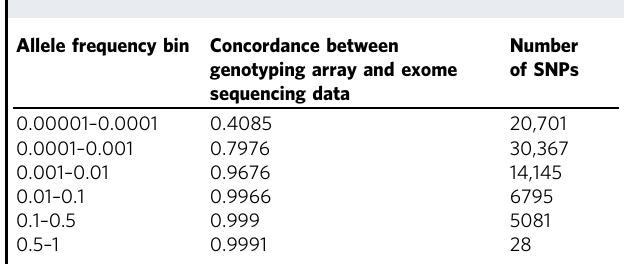
Table 1 Concordance between genotypes from In fi nium Psych Chip v1.0 and whole-exome sequencing data in a subset of 34,545 individuals in